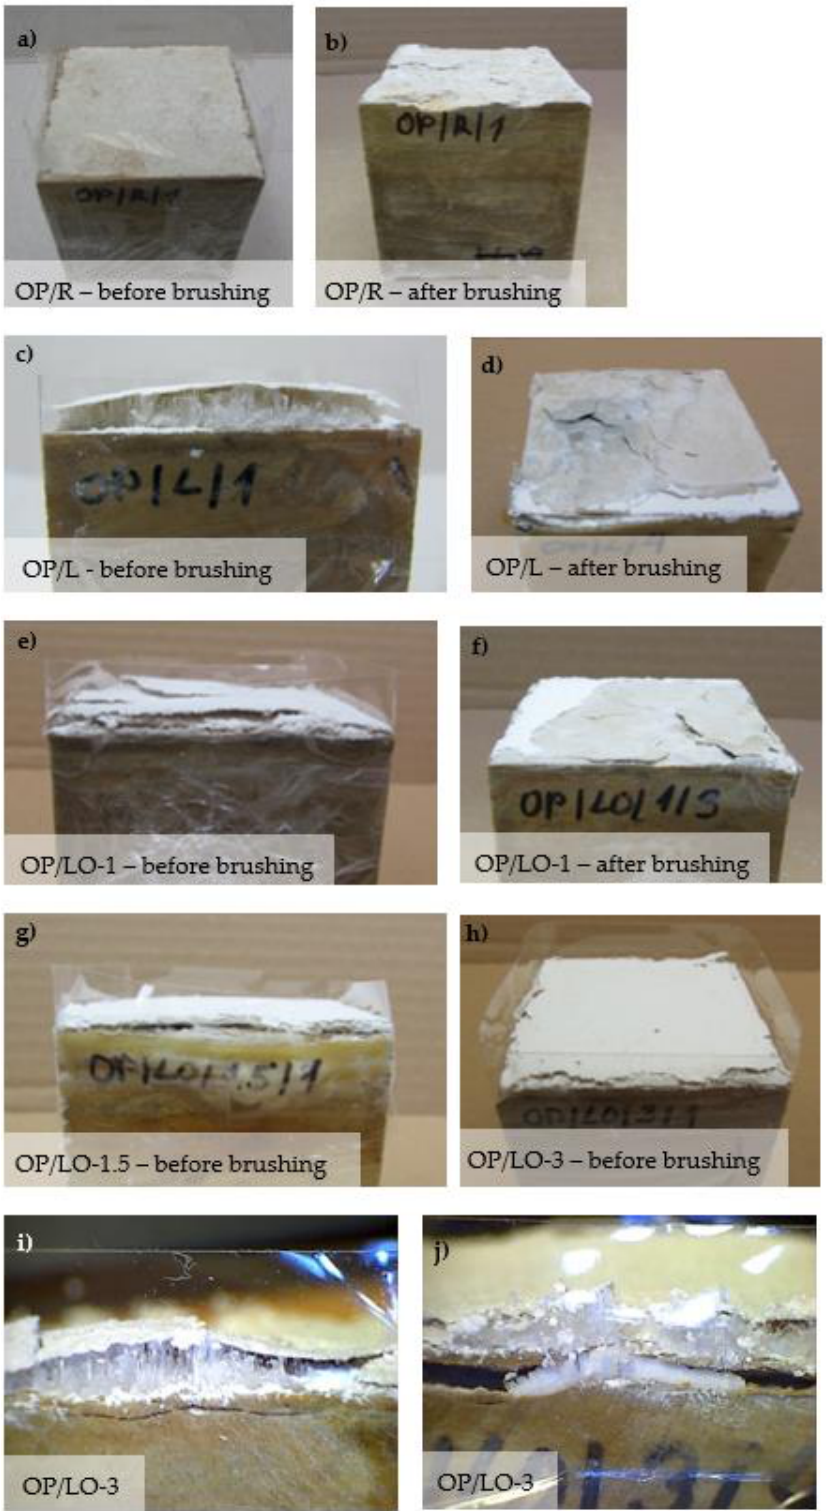
Figure 6. Opuka specimens at the end of the drying test after saturation with 1 wt.% of NaCl in respect to the specimens’ weight: ( a ) OP/R before brushing; ( b ) OP/R after brushing; ( c ) OP/L before brushing; ( d ) OP/L after brushing; ( e ) OP/LO-1 before brushing; ( f ) OP/LO-1 after brushing; ( g ) OP/LO-1.5 after brushing; ( h ) OP/LO-3 before brushing; ( i ) Detail of OP/LO-3 with salt efflorescence developing between the stone and the paint layer; ( j ) Detail of OP/LO-3 with salt efflorescence developing between the stone and the paint layer and between the stone bedding planes.